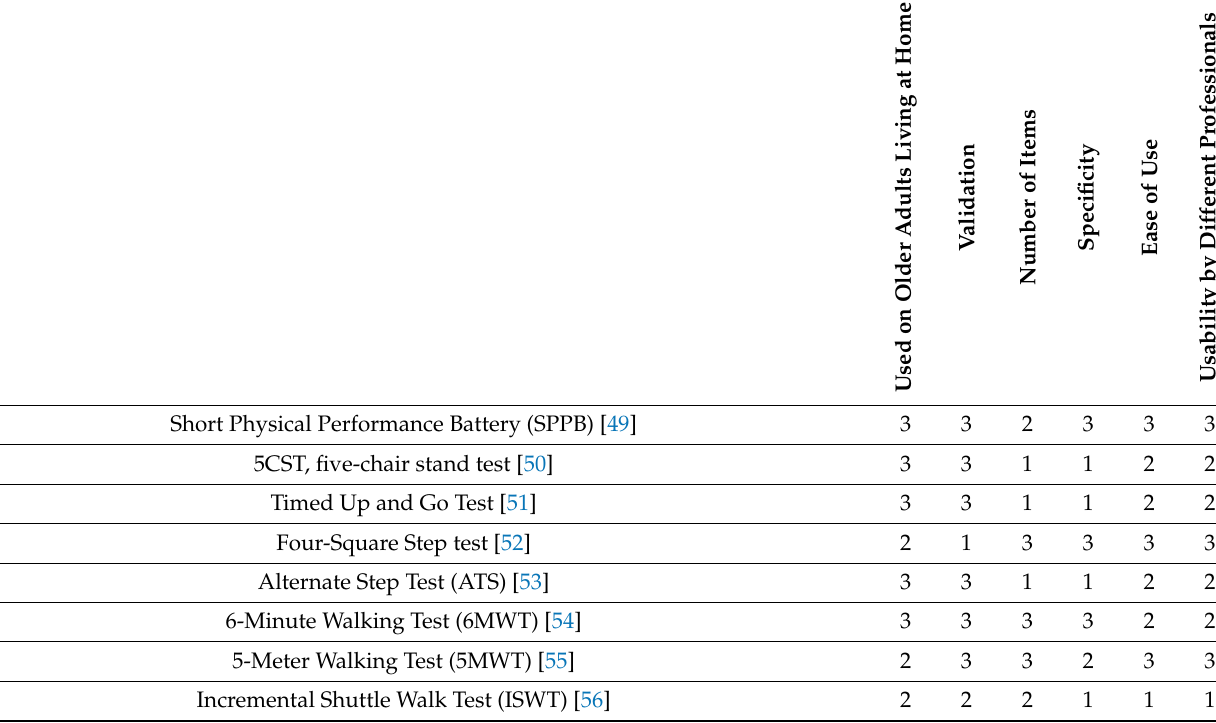
Table 4. Physical activity assessment tools